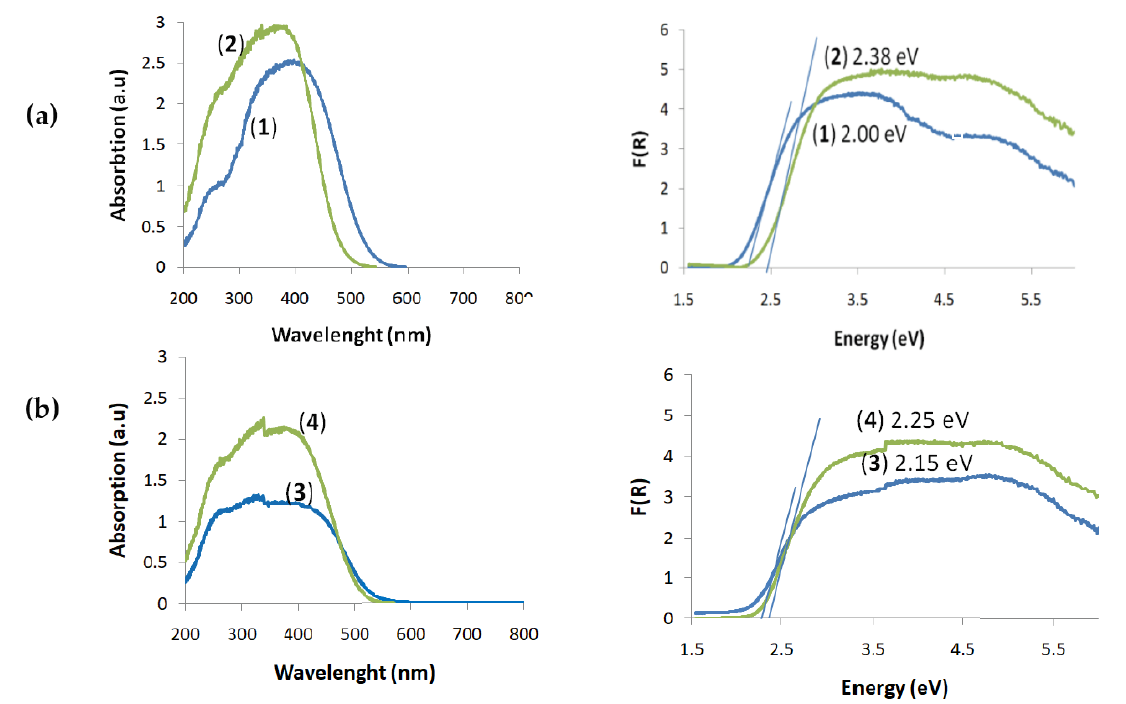
Figure 3. Solid-state UV-Vis-diffuse reflectance spectra (DRS) of the ( 1 ) – ( 4 ) micro-grains (the left side) and Kubelka-Munk function versus light energy plot for the HOMO-LUMO gap determination (the right side): ( a ) [Ti 3 O(O i Pr) 8 (O 2 CC 6 H 4 NH 2 ) 2 ] ( 1 ) and [Ti 3 O(O i Pr) 8 (O 2 CC 6 H 4 OH) 2 ] ( 2 ) and ( b ) [Ti 4 O 2 (O i Bu) 10 (O 2 CC 6 H 4 NH 2 ) 2 ] ( 3 ) and [Ti 4 O 2 (O i Bu) 10 (O 2 CC 6 H 4 OH) 2 ] ( 4 ).